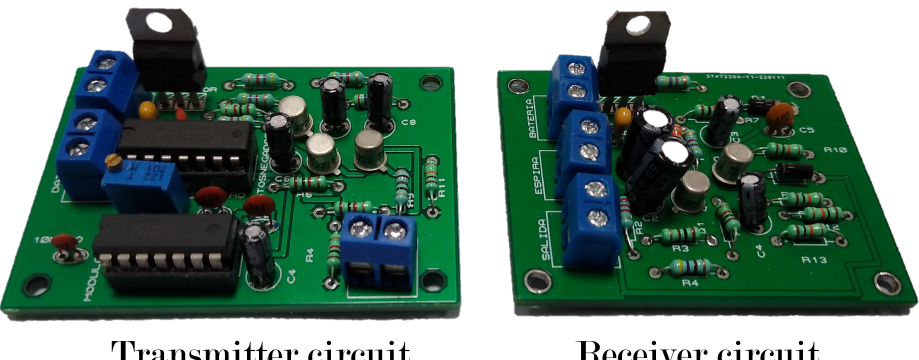
Figure 10. Construction of the transmitter and receiver